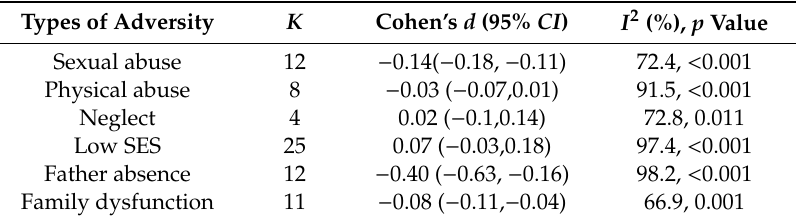
Table 2. Pooled e ff ect size of specific types of Table 2. Pooled effect size of specific types of ACEs.